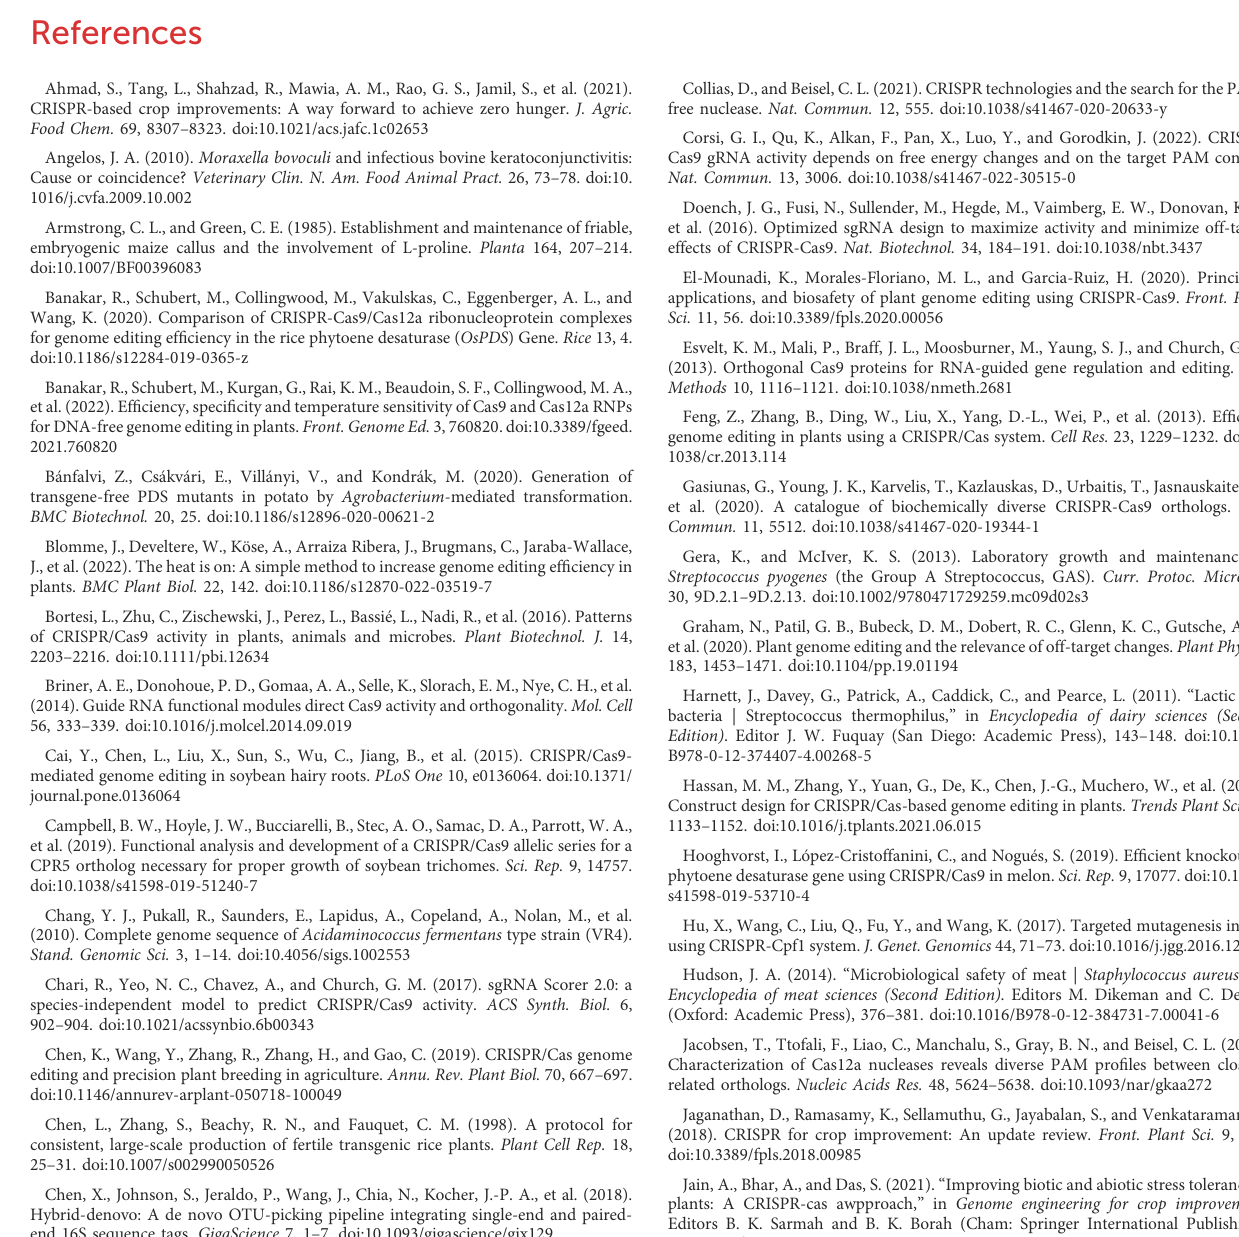
SUPPLEMENTARY TABLE S1 Relevant sequences used in this study. SUPPLEMENTARY TABLE S2 List of oligonucleotides used in this study. SUPPLEMENTARY TABLE S3 Molecular veri fi cation of editing from all newly formed hygromycin-resistant